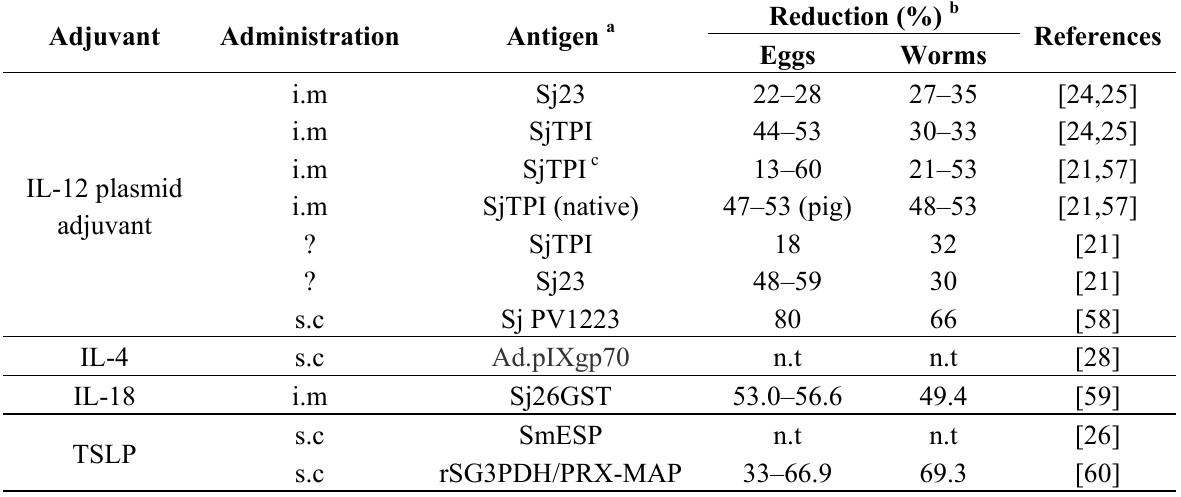
Table 6. Cytokine-adjuvanted Schistosoma vaccine candidates classified as a function of the adjuvant.